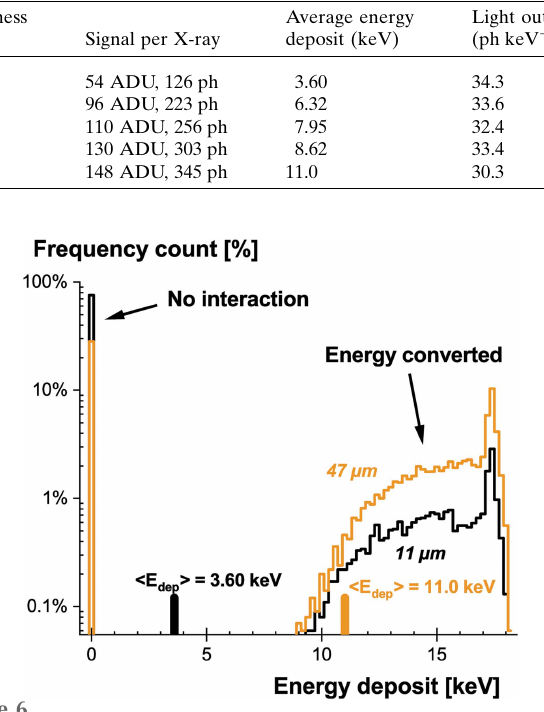
Figure 6 Geant4 simulation (10000 events) of the energy deposit in GOS:Tb scintillators of thicknesses 11 and 47 m m. The corresponding average energy deposits ( h E dep i ) are also provided.